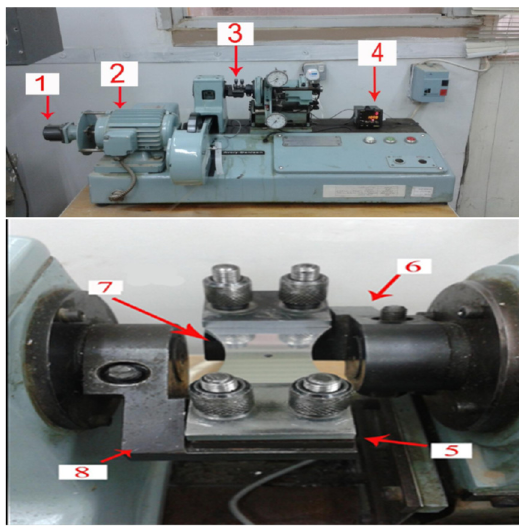
Fig. 5. Plane Bending Fatigue Testing Machine Type Avery Model 7305 1. Mechanical counter 2. Motor 3. Sample fixture 4. Digital counter 5.